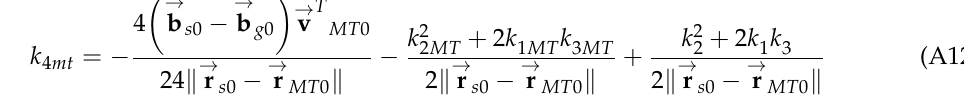
k of slant range. 3 MT